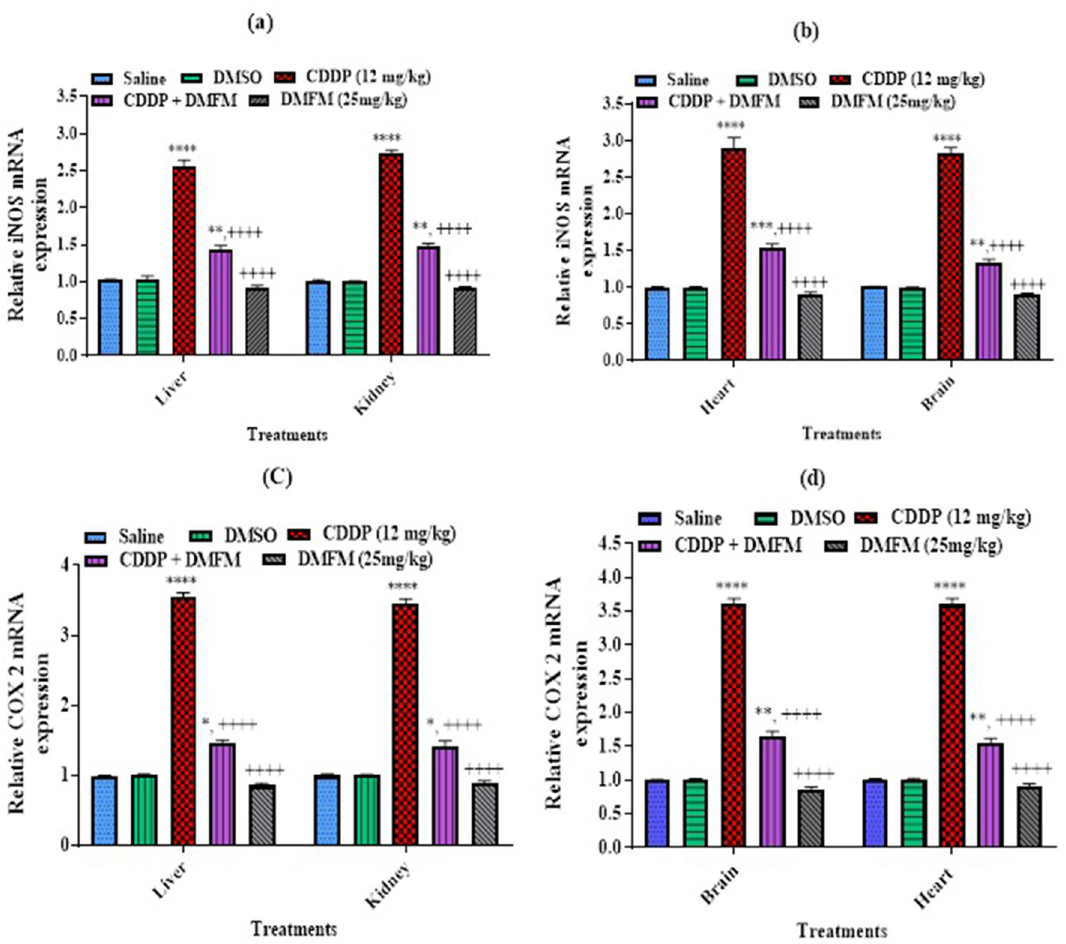
Figure 4. Quantification of mRNA expression of inflammatory mediators (COX-2, IL1 and iNOS) in various organs. *, **, ***, **** indicated p < 0.05, p < 0.01, p < 0.001 and p < 0.0001 versus saline group respectively, and ++++ P < 0.0001 versus CDDP (12 mg/kg group). Statistics was carried out by one-way ANOVA followed by the Tukey- post-test. Each value indicates the mean ± SEM (n =